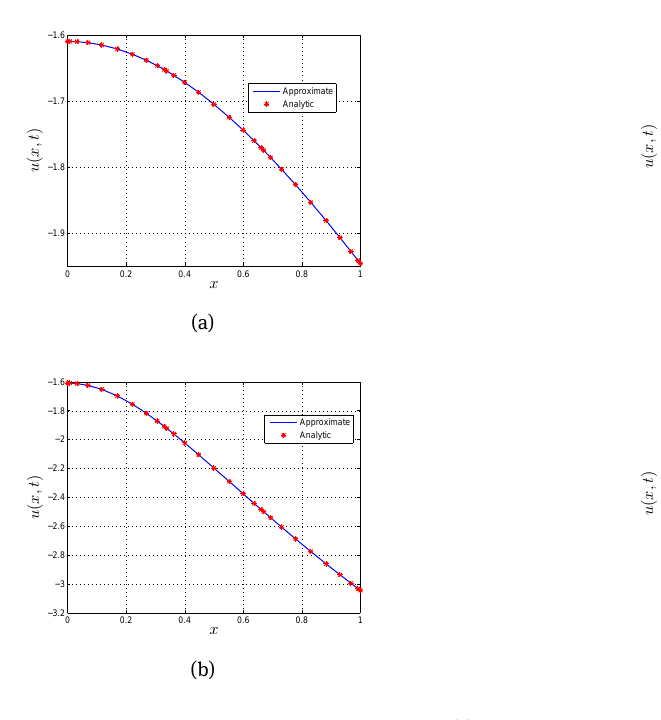
Figure 9: Space-time graph of the exact solution and approximate solution for example 2